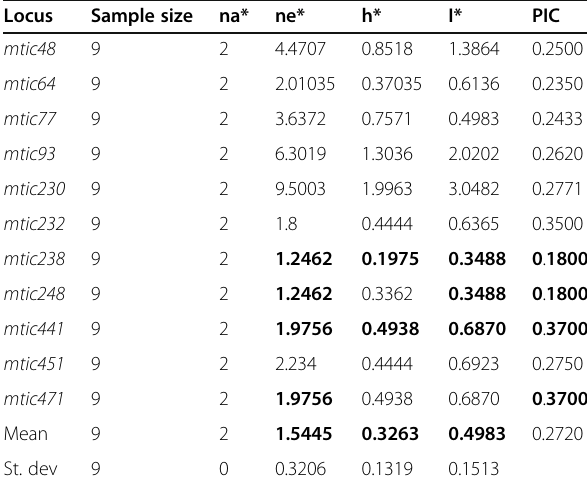
Table 4 Different genetic variations estimates for 11 transferability primers used in this study Locus Sample